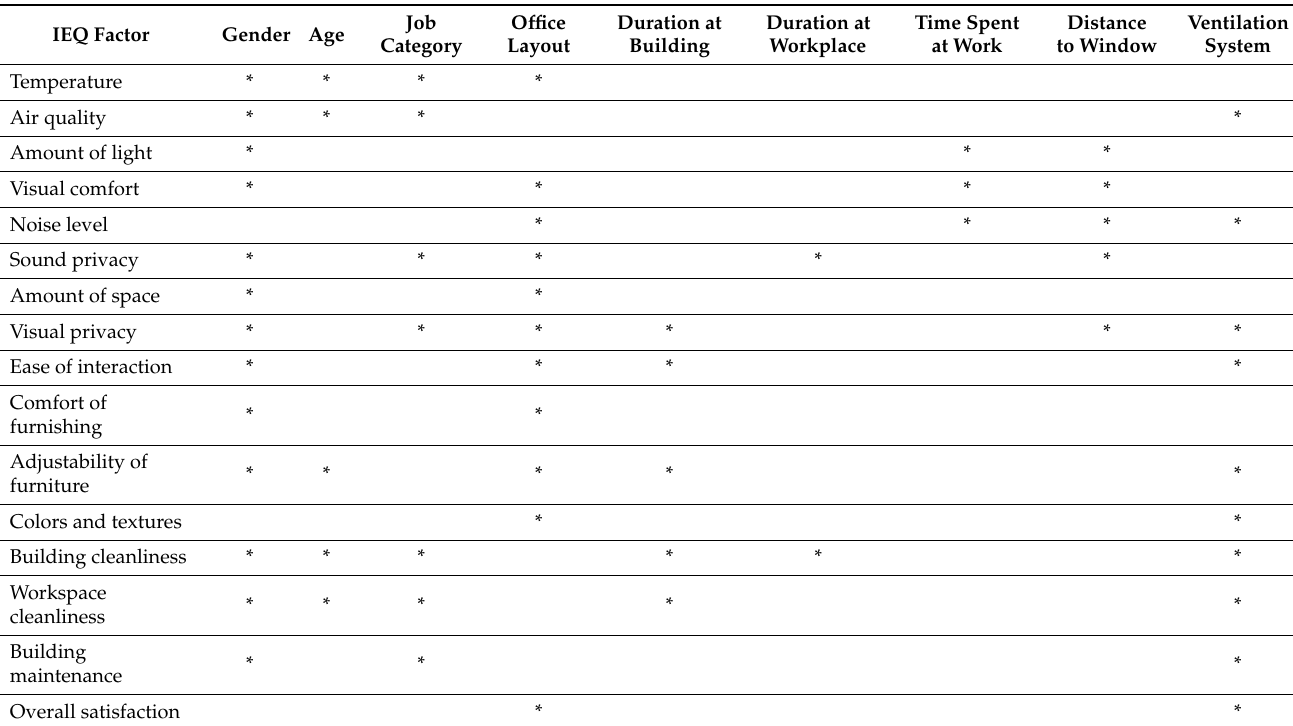
Table 5. Summary of the differences in satisfaction levels due to non-IEQ